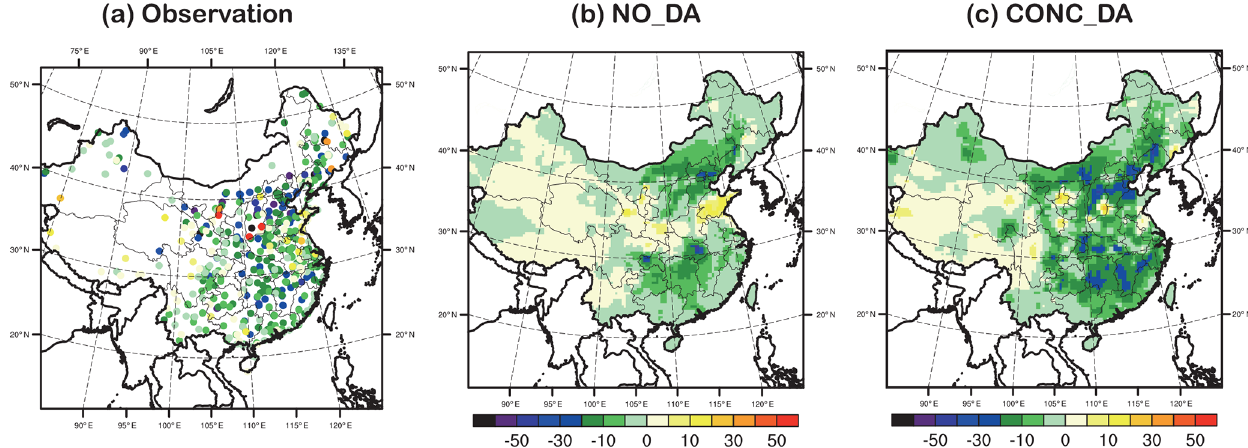
Figure 5. Observed and modeled SO 2 ambient concentration changes (January 2016–January 2015). (a) Observations, where the ranges of different colors are the same as those in the color bars of (b) and (c) ; (b) NO_DA; and (c) CONC_DA. (Units: µgm − 3